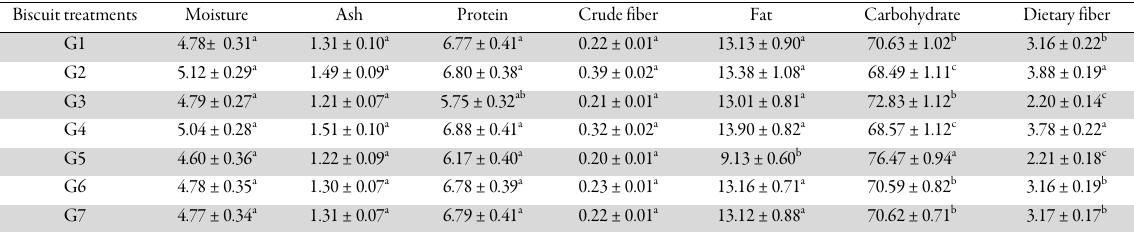
carbohydrate contents ranged from 2.23 to 2.63%, 2.45 to 4.35% and 64.77 to 69.86%, respectively. There was significant increase in protein and fiber content of biscuits with addition of cocoa powder with the high protein and fiber contents observed in samples compared of control. Biscuits formulated with synthetic color 7.5 mg/kg tartrazien had a slightly low content of moisture, ash, protein, crud fiber, fat, dietary fiber and carbohydrates as compared with control biscuits . The same trend for biscuits formulated with0.15 mg/kg of chocolate brown had a slightly low contents of protein, fiber, fat, dietary fiber and slightly low content of carbohydrates than that of control biscuits. On the other hand, biscuits made mixture synthetic color and natural color had the same values of protein, fiber, fat and dietary fiber as compared with biscuits control. Table 4. Chemical composition (%) of colored wheat flour biscuit Biscuit treatments Moisture Ash